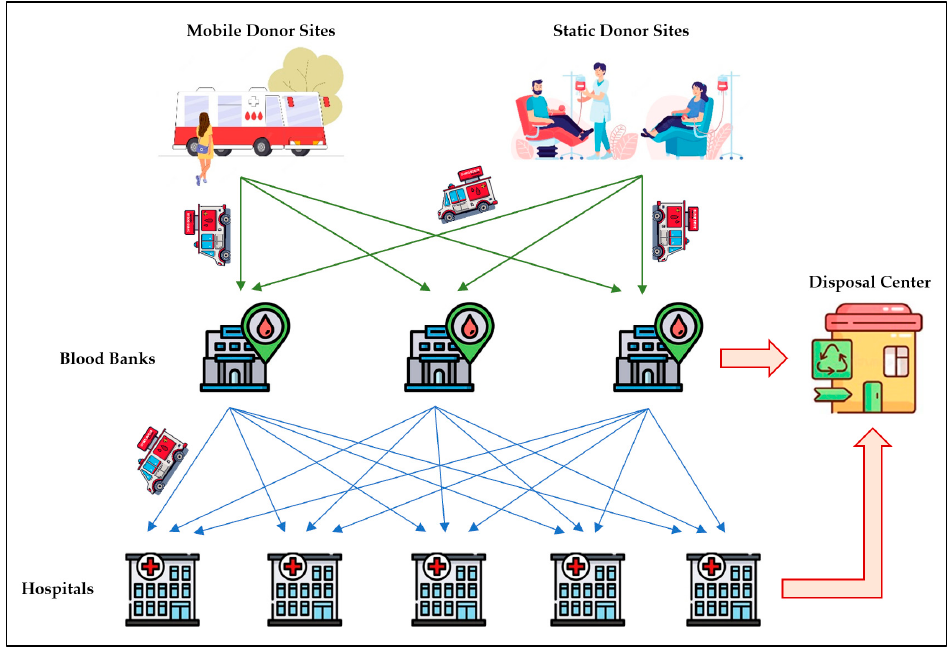
Figure 1. Three-echelon BPSCN model with vertical–horizontal transshipment.